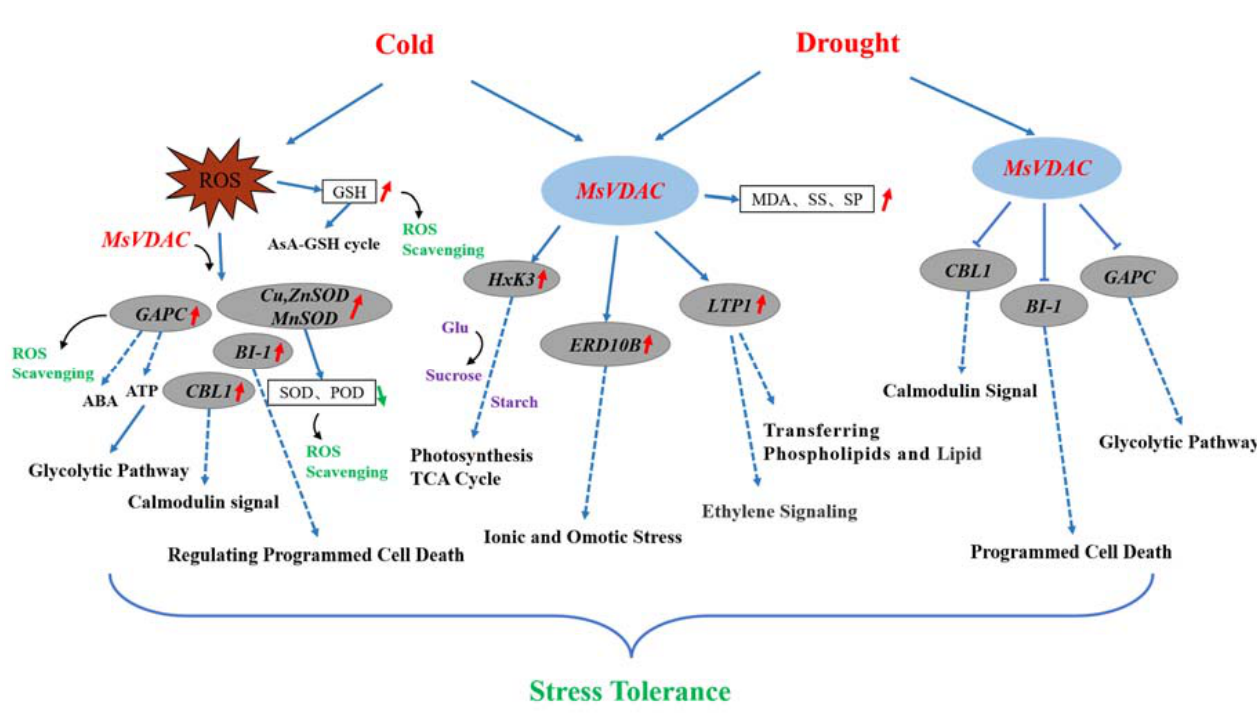
Figure 6. Possible molecular mechanisms through which MsVDAC functions in response to cold and drought stress. The red arrows indicate upregulation of stress-response genes or increases in physiological indicators. The possible regulatory mechanisms are shown with dotted lines.